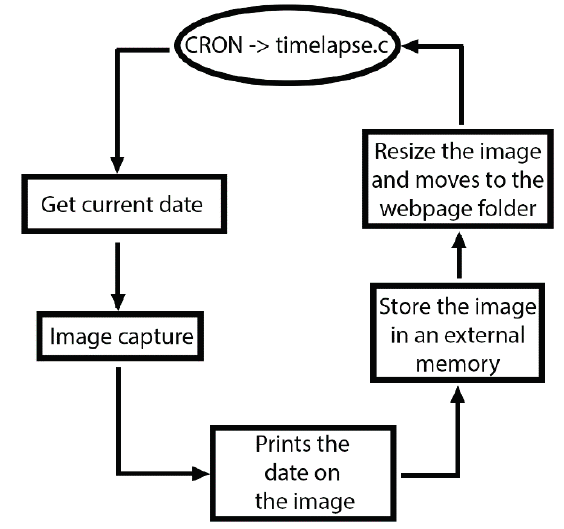
Figure 8. Flowchart of the timelapse.c